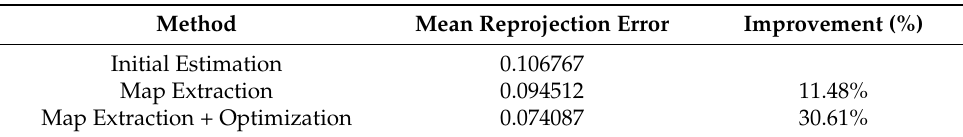
Table 1. The result of the ablation study.